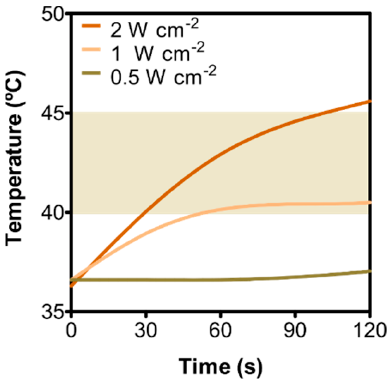
Figure 3. Time evolution of the temperature of TAT–PLGA(DOXO-BMNPs) suspension at different laser power densities.